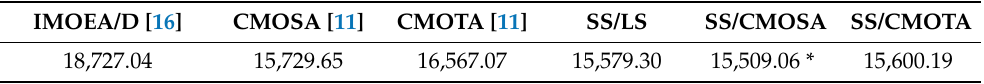
Table 2. IMOEA/D, CMOSA, CMOTA, SS/LS, SS/CMOSA, and SS/CMOTA results using MID.